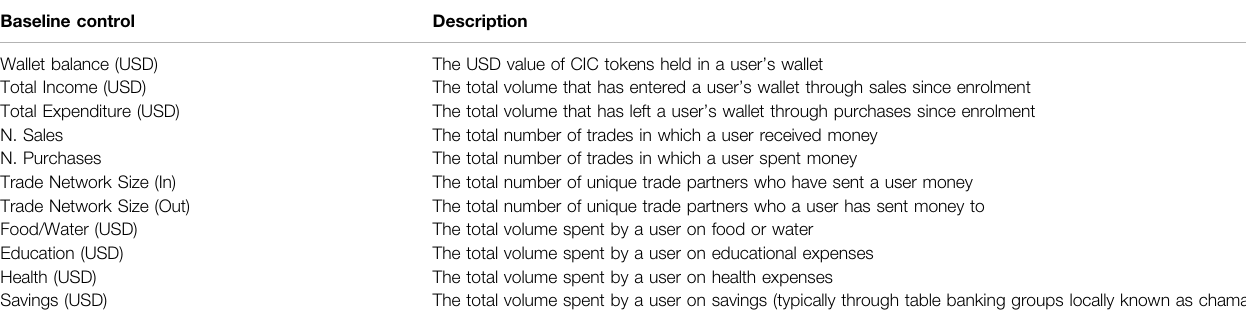
TABLE 2 | Baseline controls (recorded 1 day before treatment intervention).